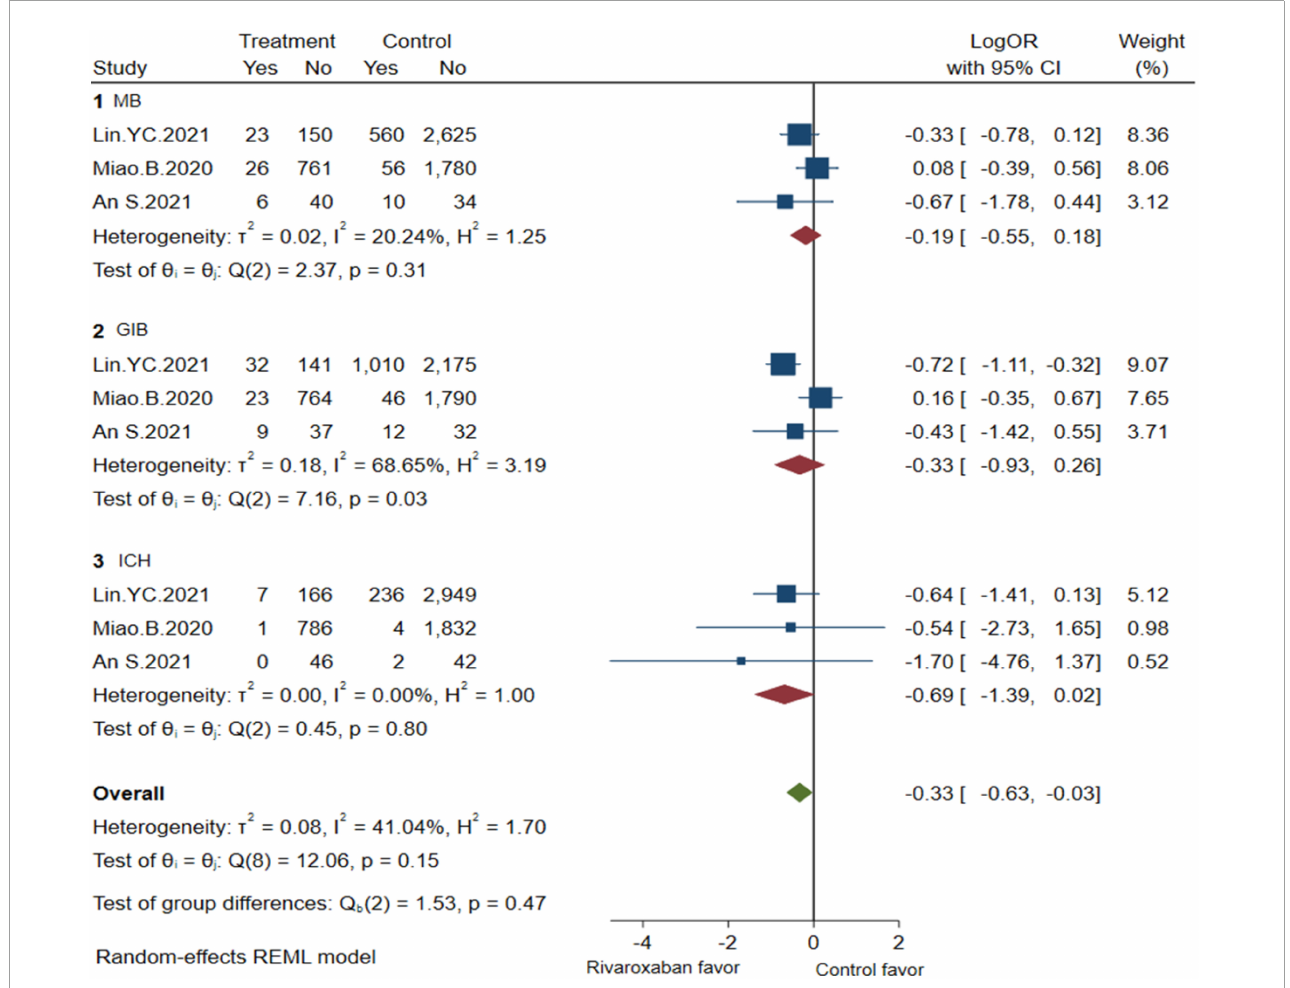
FIGURE3 Bleeding of mix-dose rivaroxaban (MB, major bleeding; GIB, gastrointestinal bleeding; ICH, hemorrhagic stroke).